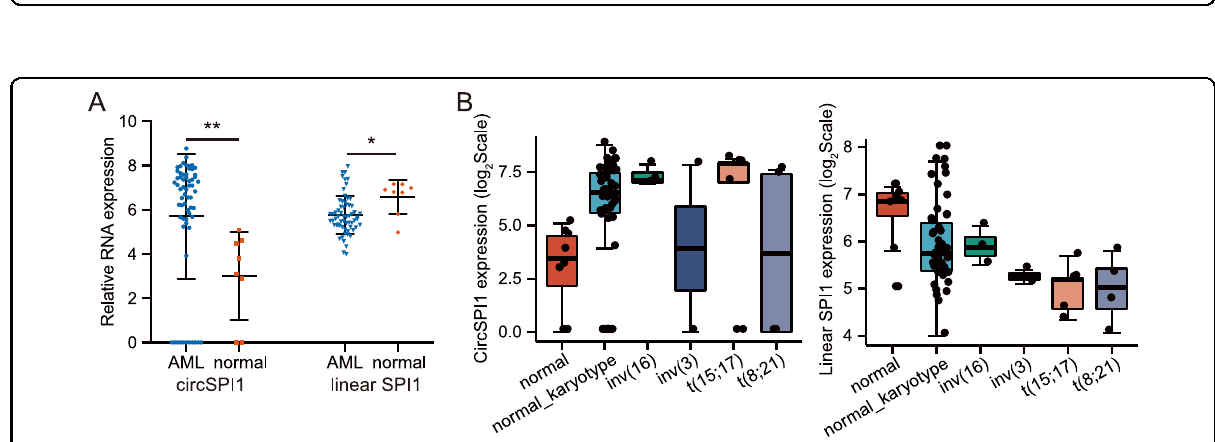
Fig. 2 CircSPI1 is speci fi cally upregulated in AML. A The relative expression levels of circSPI1 and linear SPI1 in AML patients ( N = 62) and healthy normal subjects ( N = 8). B The expression levels of circSPI1 (left panel) and linear SPI1 (right panel) in AML patients with different karyotypes. Ribo- zero RNA-sequencing data of 48 AML samples with normal karyotype, including 5 APL patients, 4 t (8; 21) translocation, 3 inv(16), 2 inv(3), and 8 normal individuals, were retrieved and analyzed. * P < 0.05, ** P <